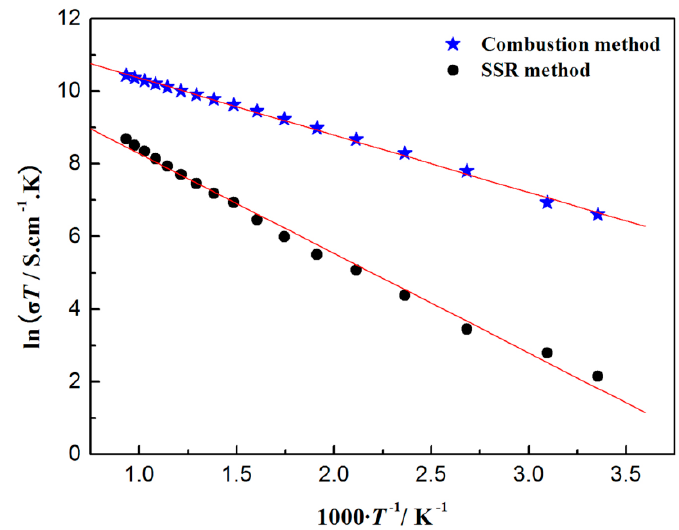
Figure 4. Plots of ln( σ e T ) versus 1000 / T for La 0.8 Ca 0.2 CrO 3 ceramics synthesized by the different methods.